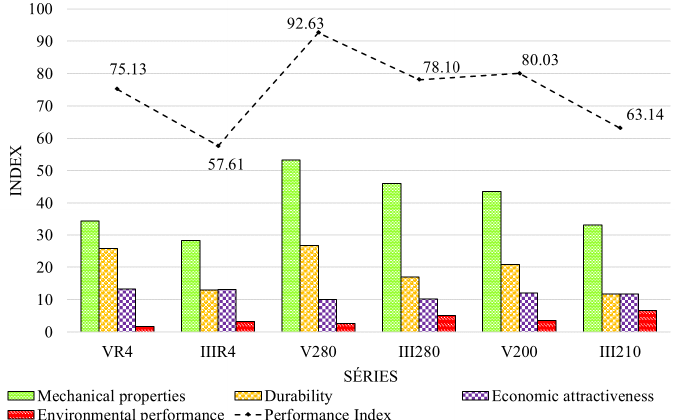
Figure 4. Partial indices of criteria and final performance index - Scenario 2 (building structure).